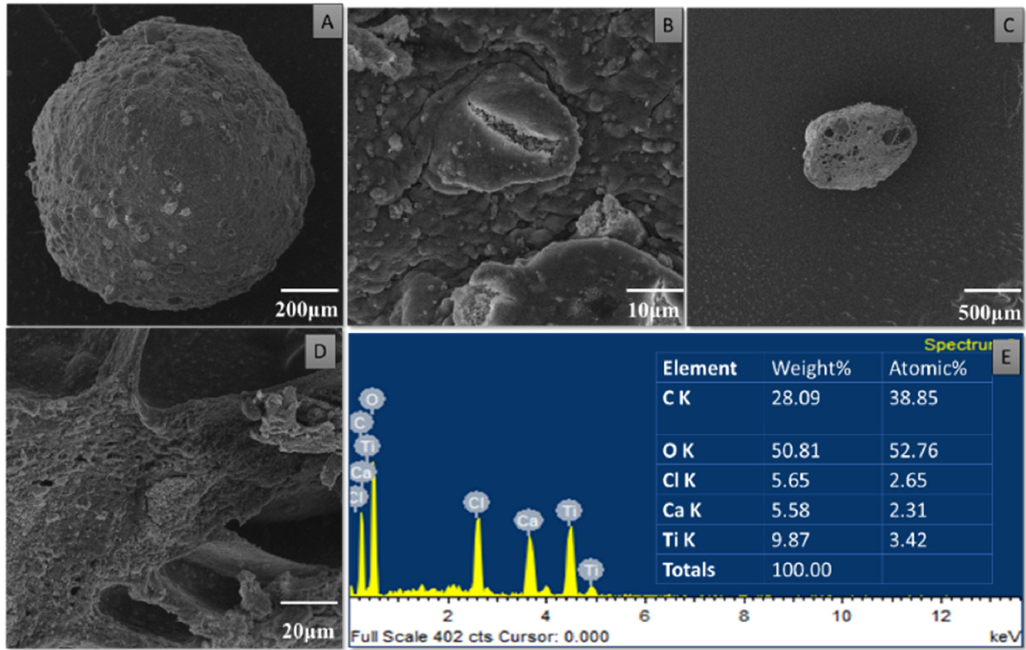
Figure 7. SEM/EDX of CI-TiO 2 -MS. SEM image of CI-TiO 2 -MS at low magnification ( A ) and high magnification ( B ). Cross-sectional SEM images of CI-TiO 2 -MS at low magnification ( C ) and high magnification ( D ). EDX of CI-TiO 2 -MS ( E ).